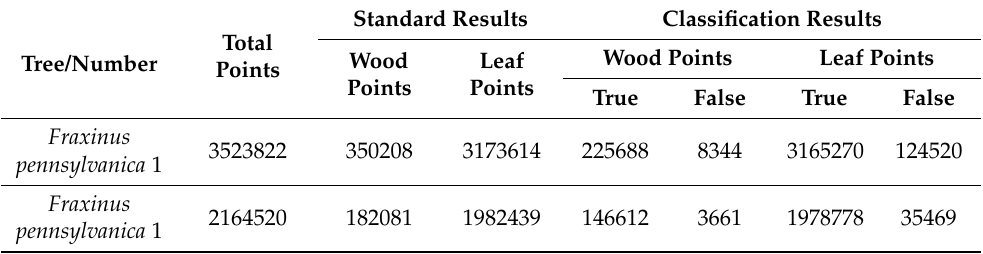
Table 6. The point statistics information of two Fraxinus pennsylvanica trees classification results.